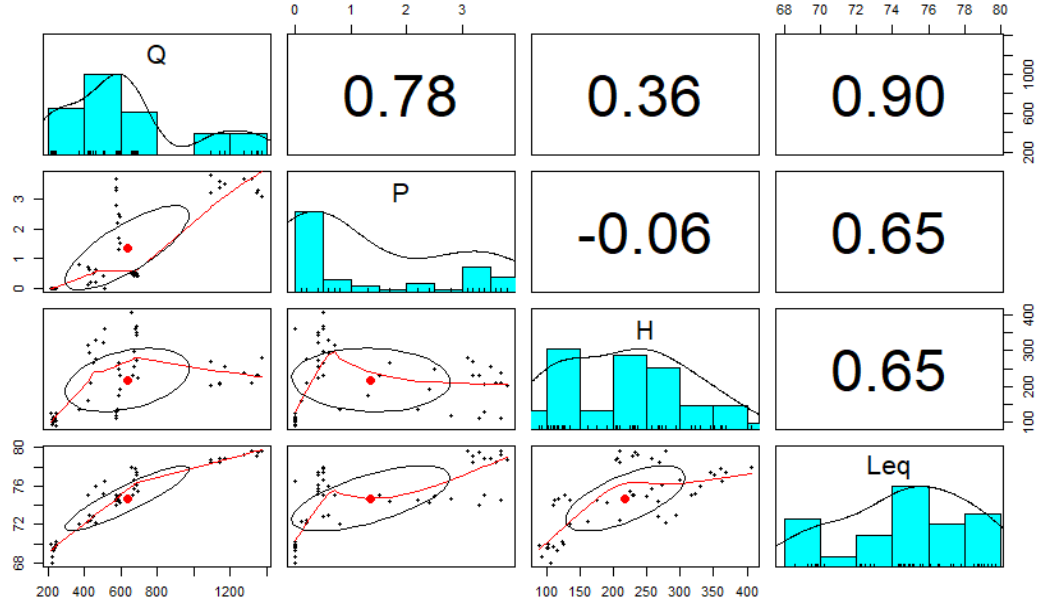
Figure 3. Scatter plot of traffic volume (Q), heavy vehicles percentage (P), honking occurrences (H) and measured continuous equivalent levels ( L eq ), with bivariate scatter plots below the diagonal, histograms on the diagonal and the Pearson correlation above the diagonal.